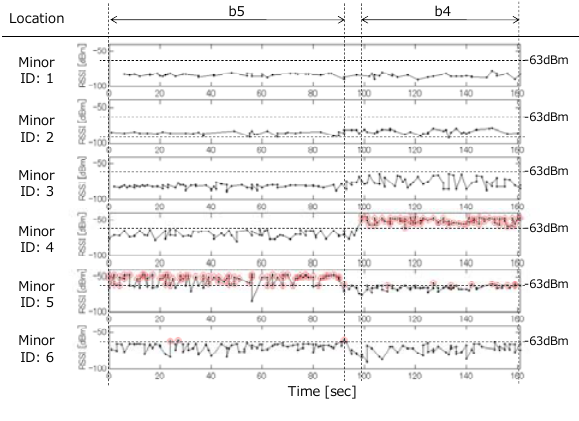
Figure 14. Measured RSS values